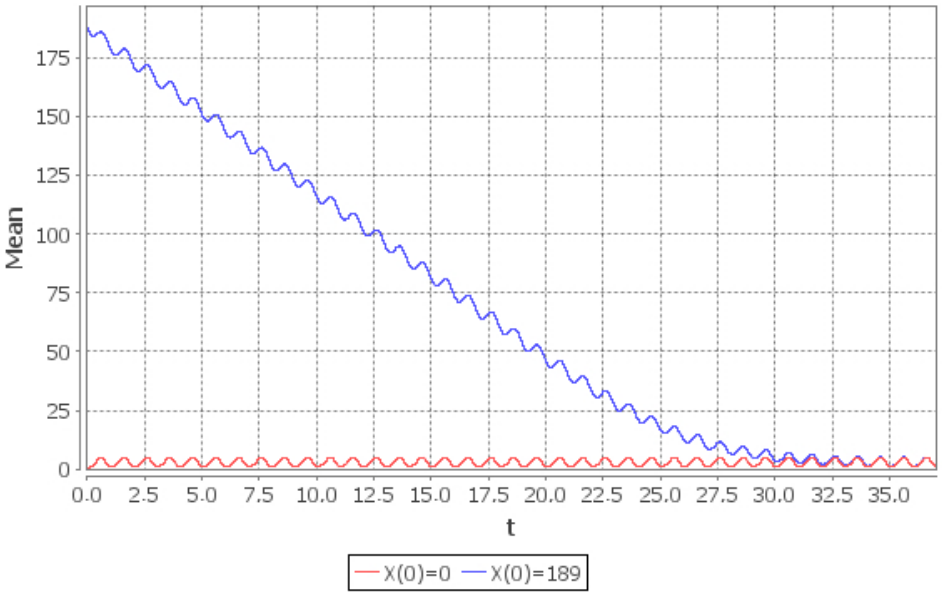
Figure 3. Rate of convergence of the conditional mean E ( t , k ) number of customers in the system in the interval [ 0,37 ] : E ( t ,0 ) ( red line ), E ( t ,189 ) ( blue line ).